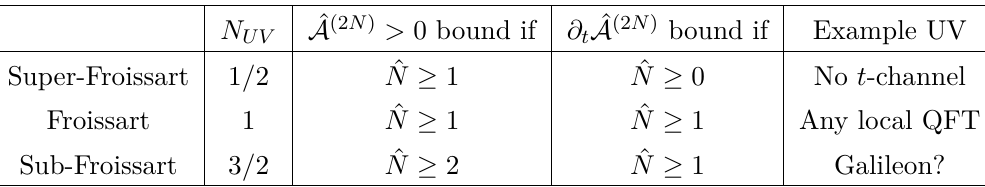
Table 1 . Summary of three different high-energy growths (4.12) of the amplitude in the UV and the corresponding positivity